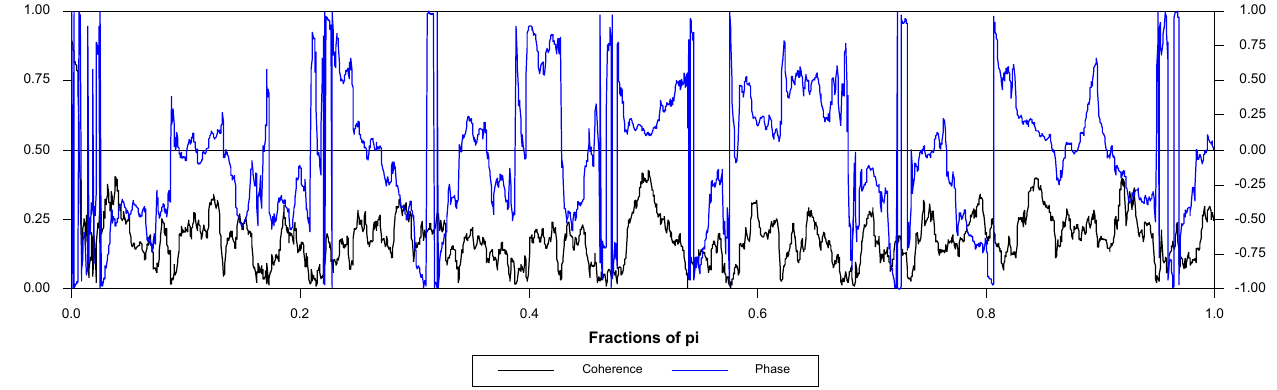
Figure 7. Coherence and phase diagrams of detrended SPRB and CU.